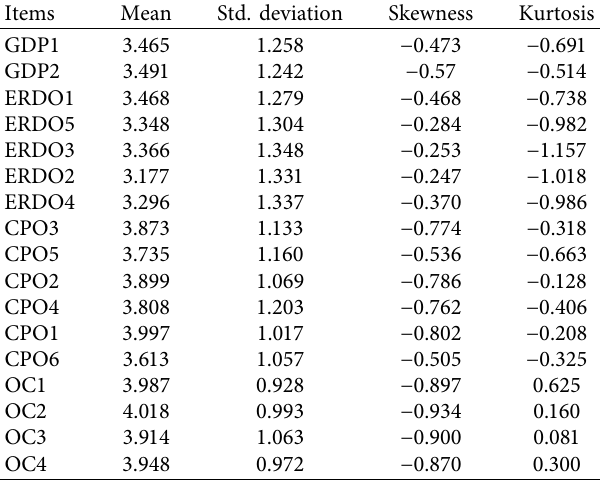
Table 3: Descriptive statistics.